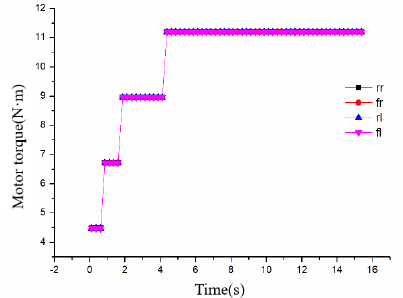
Figure 8. Motor output torque of non-controlled strategy.